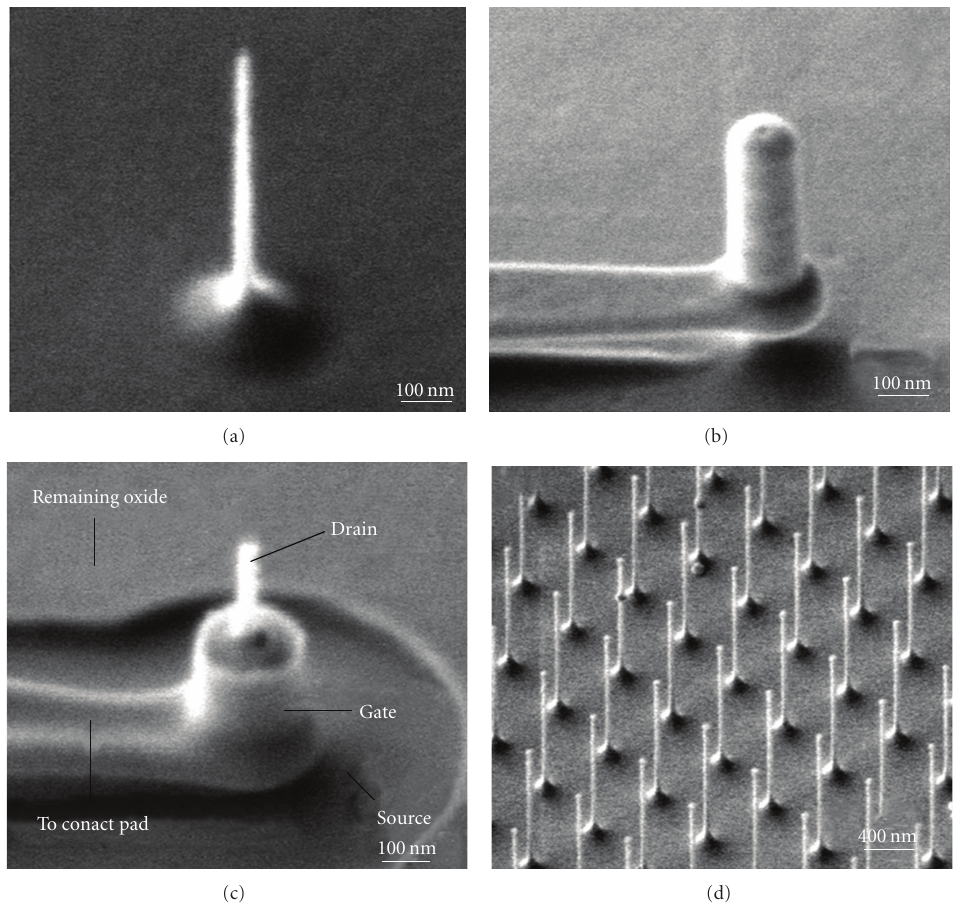
Figure 3: SEM pictures at di ff erent stages of device fabrication. (a) Vertical nanowire with diameter ∼ 20 nm; (b) after gate patterning by lithography but before exposing the drain (the tip of the pillar) of the transistor; (c) after the drain (pillar tip) is exposed, ready for taking metal contacts, (d) vertical nanowire arrays with pitch of 500 nm. Nanowires are 1 μ m tall with a diameter of ∼ 20nm. (Reprinted with permission from [15]. [2008]